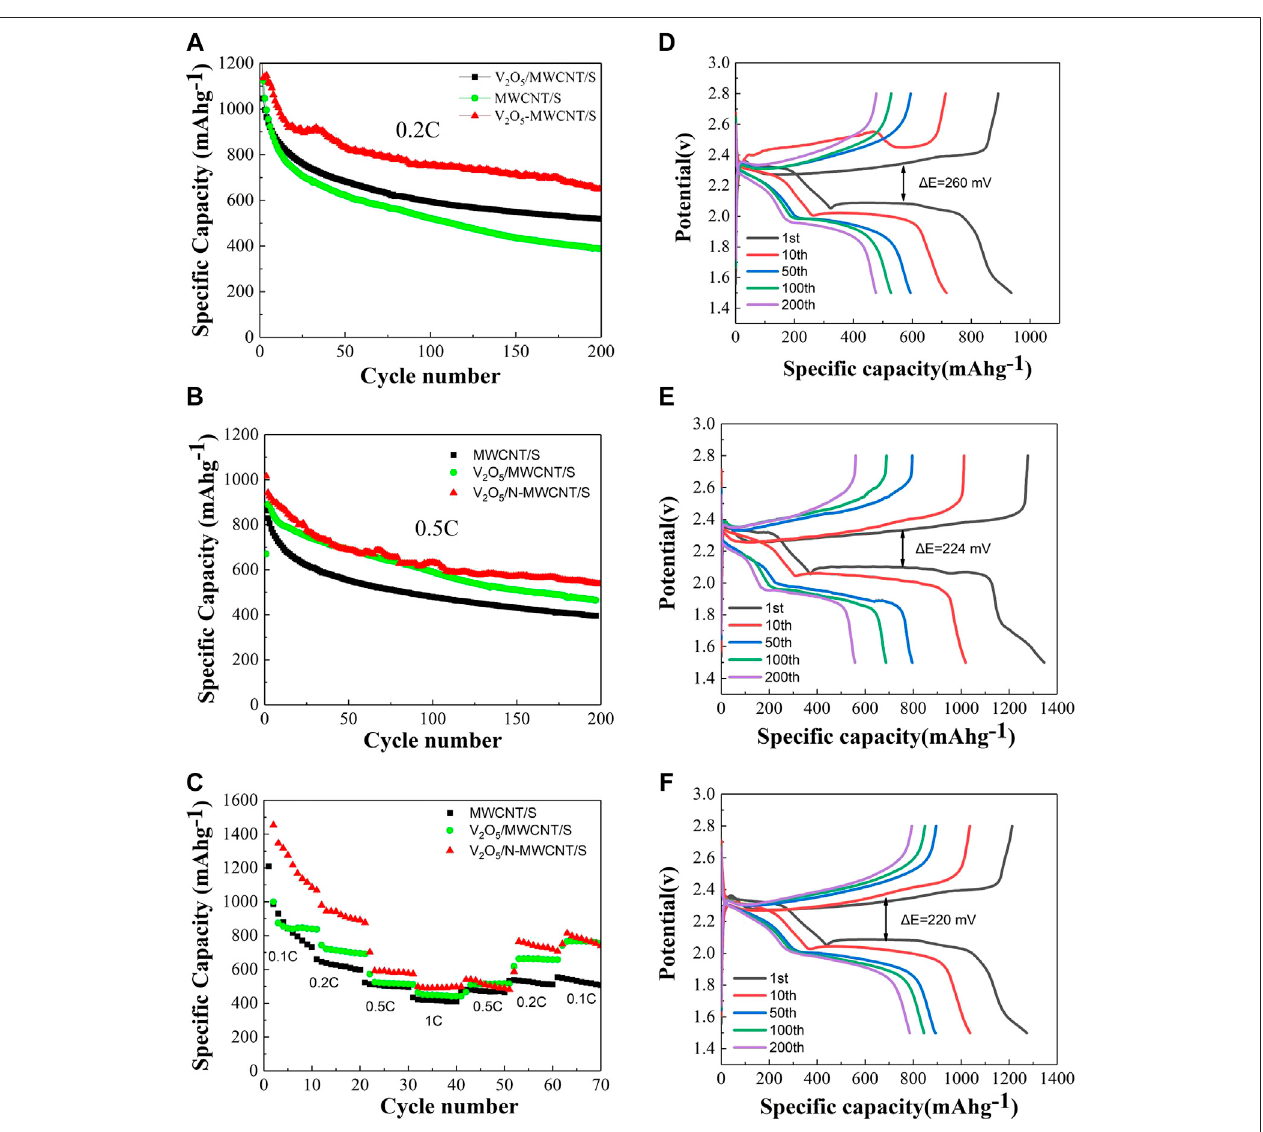
FIGURE 6 | (A – C) Cycle performance of the V 2 O 5 /N-MWCNT/S, V 2 O 5 /MWCNT/S, and MWCNT/S composite materials at 0.2, 0.5, and 1 C (D – F) Cycle